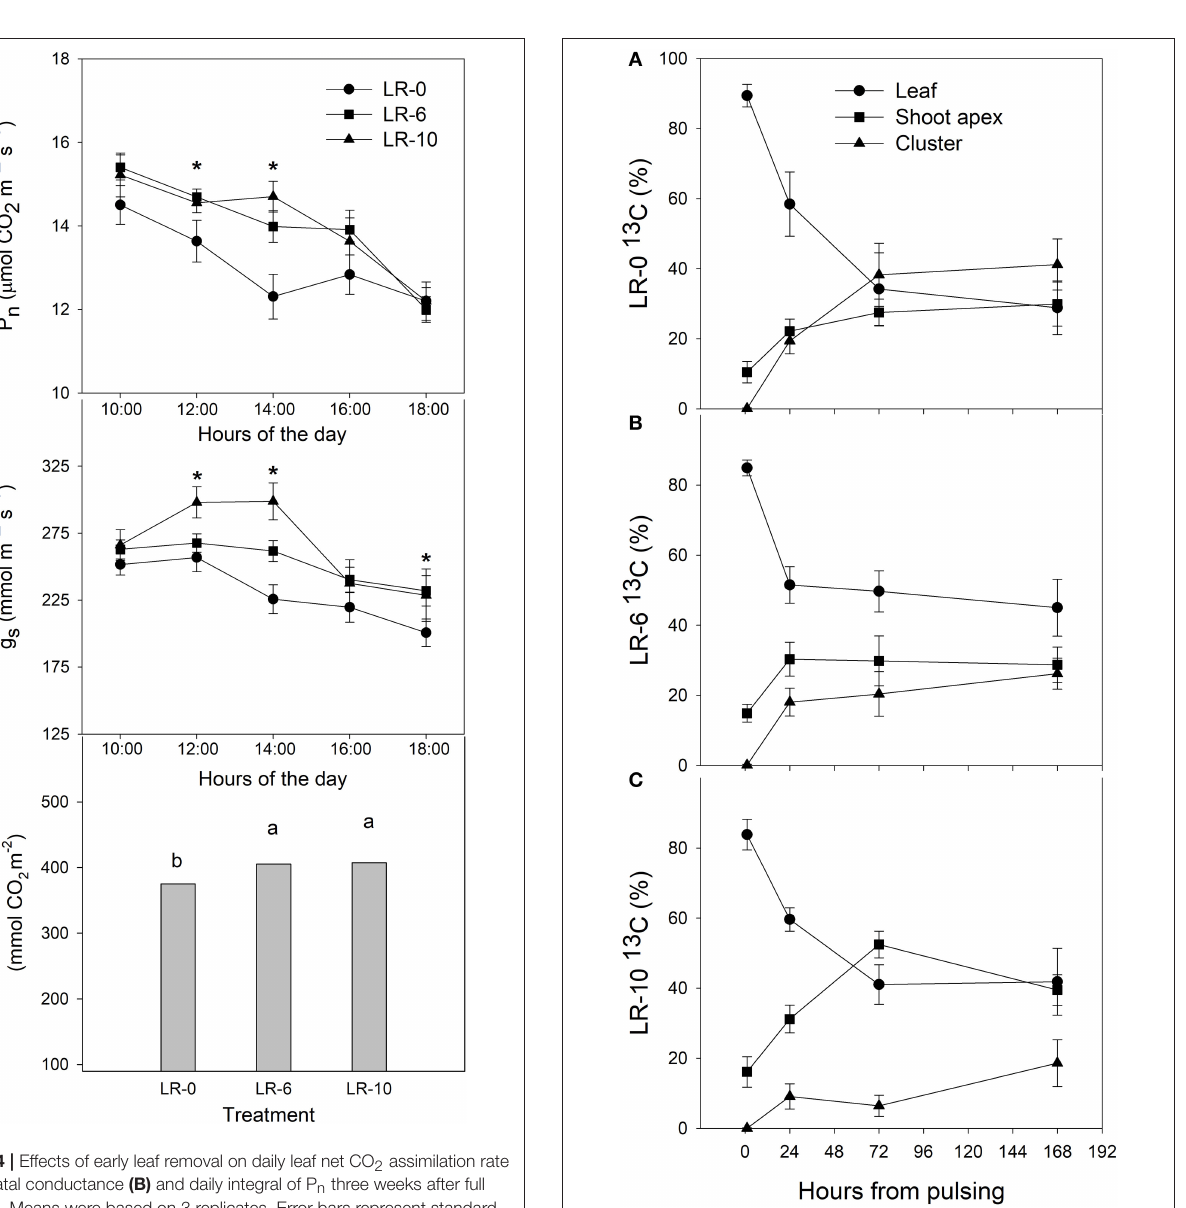
FIGURE 5 | Distribution (%) of 13 C in leaf, shoot apex and cluster of grapevine subjected to different intensity of leaf removal from 1 to 168h after 13 CO 2 pulsing. Each point represents the mean of 4 values ± SE. Hour 0 represents the moment of pulsing and correspond to 7 days after leaf removal and therefore 7 days after full bloom. Symbol (*) represent significant difference at P < 0.05. LR-0, no leaves removed (A) ; LR-6, leaves removed from 6 basal nodes (B) ; LR-10, leaves removed from 10 basal nodes at bloom (C)